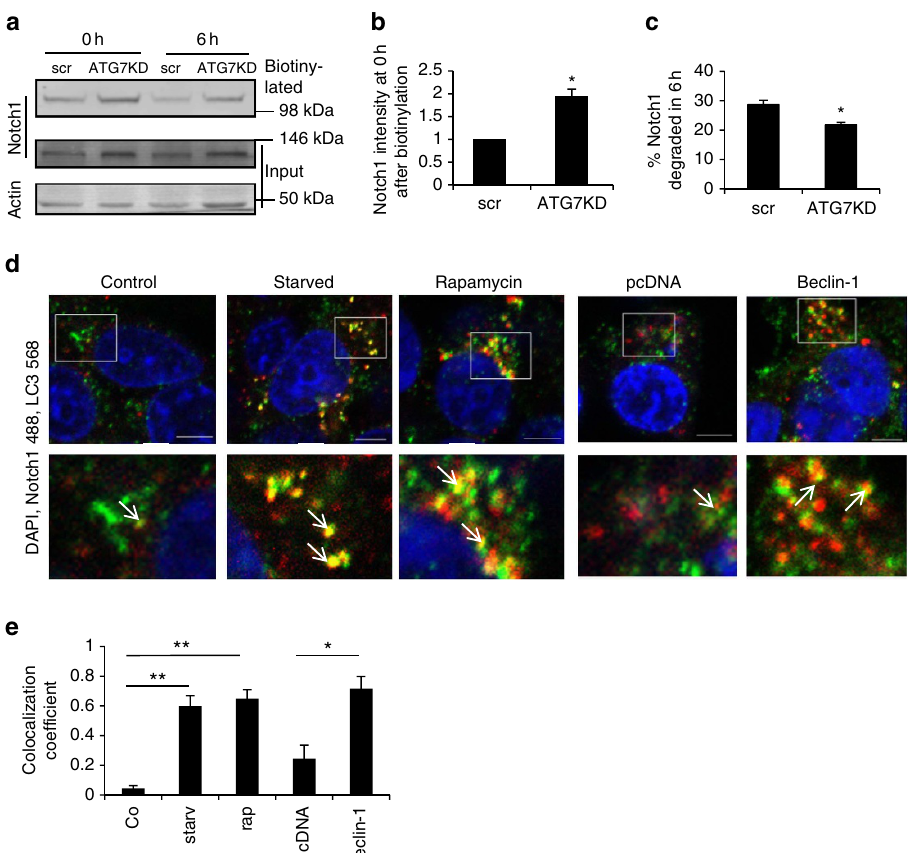
Figure 2 | Autophagy regulates Notch1 degradation. ( a ) Effect of autophagy inhibition on degradation of Notch1 was assessed by biotinylation assay in HEK cells treated with ATG7 siRNA (ATG7KD). The cell surface proteins were biotinylated and cells were immediately collected or incubated at 37 (cid:2) C for 6h to allow internalization and degradation. After lysis, biotinylated proteins were pulled down with streptavidin beads and the amount of biotinylated Notch1 remaining assessed by western blot (top panel). Western blots for total Notch1 levels and actin levels in the input are shown as controls. ( b ) Quantification of surface Notch1 at time point 0h after autophagy inhibition. * P o 0.05 by paired t -test. n ¼ 3. Error bars ¼ s.e.m. ( c ) Quantification of Notch1 degradation rate. The ratio of 6h/0h biotinylated Notch1 level is shown for scrambled siRNA (scr) and ATG7KD samples. * P o 0.05 by unpaired t -test. n ¼ 3. Error bars ¼ s.e.m. ( d ) HEK cells were starved with HBSS (2h) or treated with DMSO (control) /rapamycin or transfected with pcDNA or Beclin-Flag (2 days). Cells were immunostained for Notch1 (green) and LC3 (red) and stained with DAPI (blue). The white box indicates the location of the enlargement. The arrows show LC3 and Notch1 colocalization. Scale bar, 5 m m ( e ) Colocalization of Notch1 with LC3 from 2 days (starv ¼ starved, rap ¼ rapamycin). Mander’s colocalization coefficient was measured using Volocity software. Unpaired t -test ** P o 0.01. * P o 0.05. n ¼ 3. Error bars ¼ s.e.m.